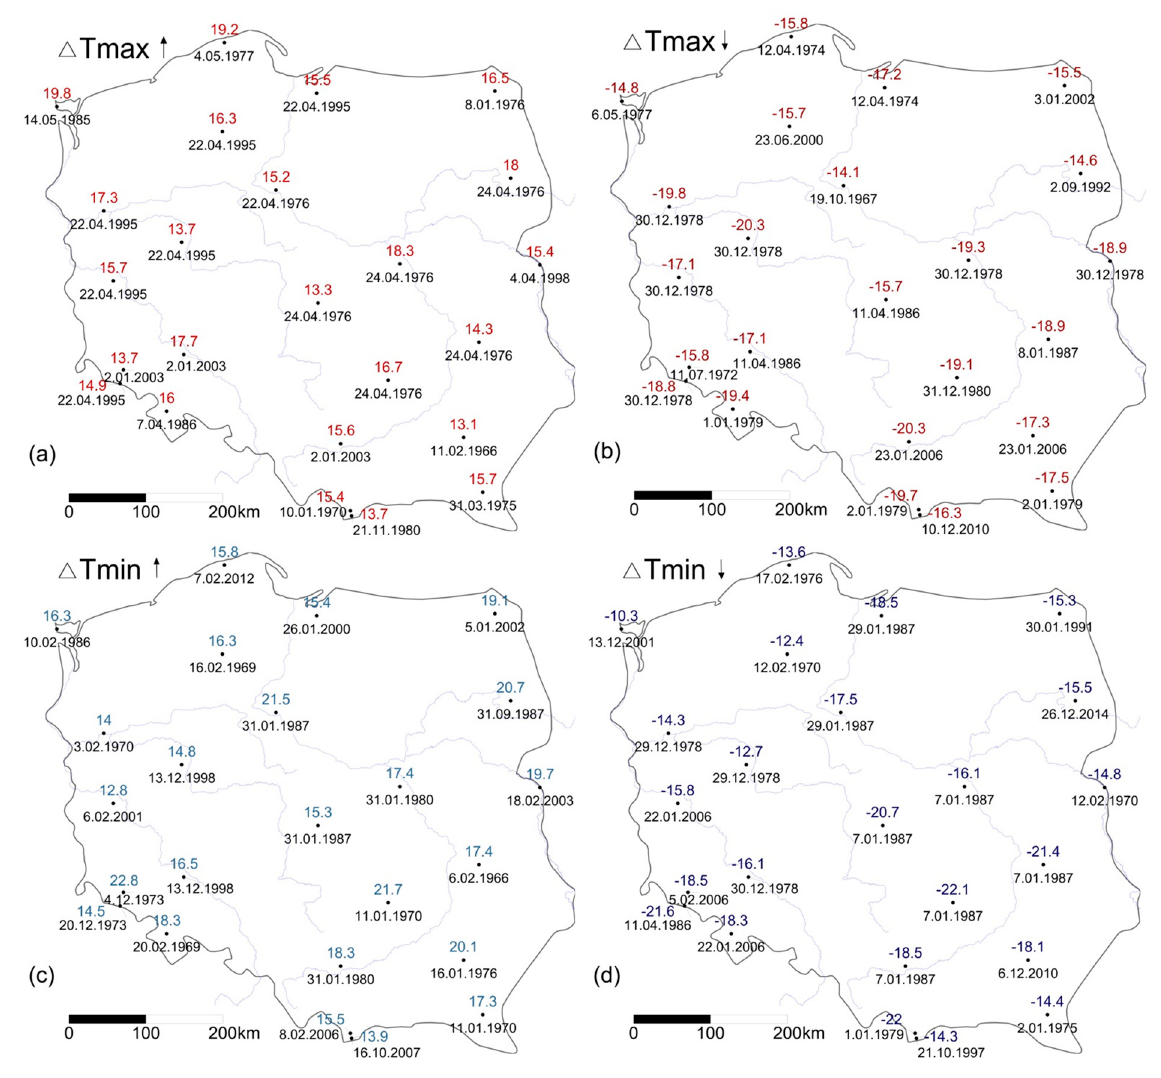
Figure 10. The highest interdiurnal increases and decreases in Tmax ( a , b ) and Tmin ( c , d ) in Poland in 1966–2015 with the date of its occurrence.